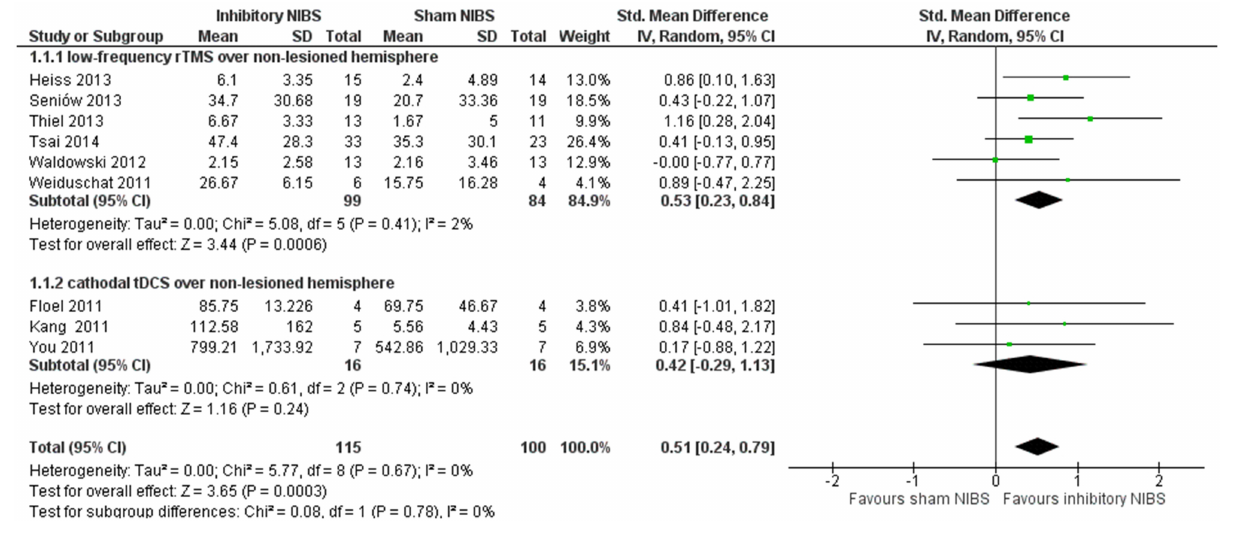
FIGURE 1 | Meta-analysis by inhibitory non-invasive brain stimulation (NIBS) (low-frequency rTMS and cathodal tDCS) vs. sham NIBS over the non-lesioned non-language dominant hemisphere. Forest plot of SMD and 95% CI for the outcome of